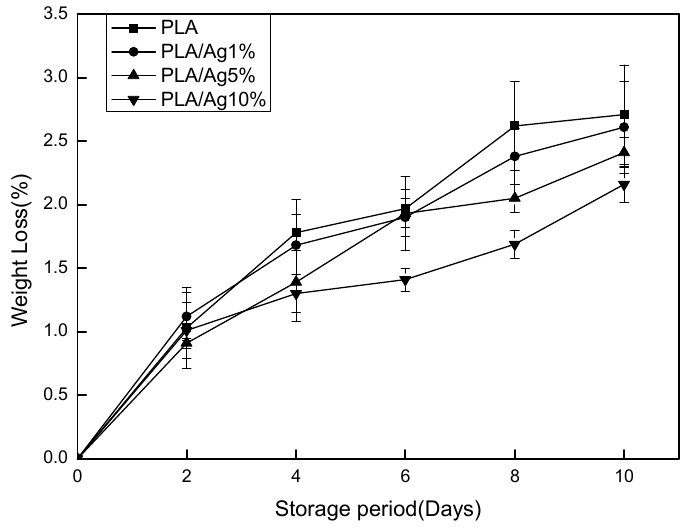
Figure 1. Effect of different concentration of nano-Ag active packages on weight loss of strawberry stored at 4 ± 1 °C for 10 days. Data are presented as mean ± standard deviation.